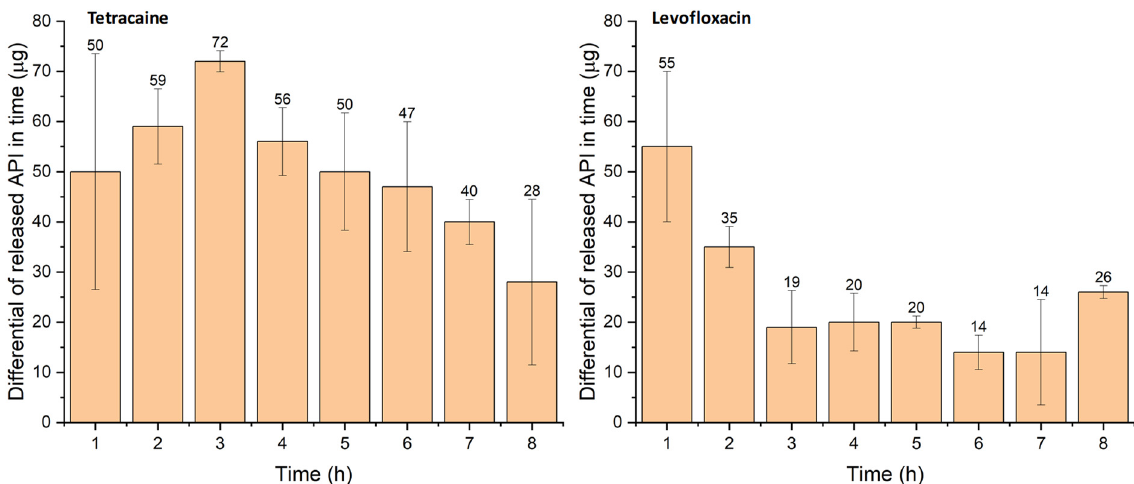
Figure 7. Dependence of released amount ( μ g) of drug from the carrier on time ( left —Tetracaine, right —Levofloxacin). The number of samples was 3 for each measurement.